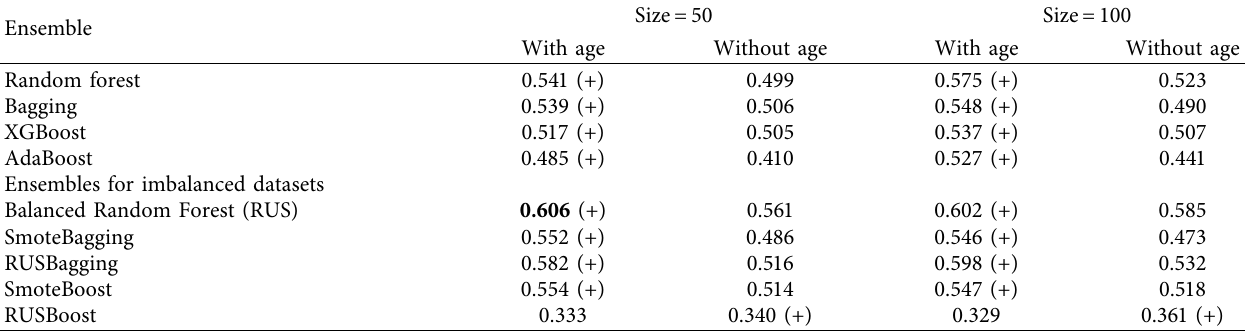
Table 8: The effect of age variable on the performance (AUPRC) of various ensembles. “+” sign shows the better performance of with age or without